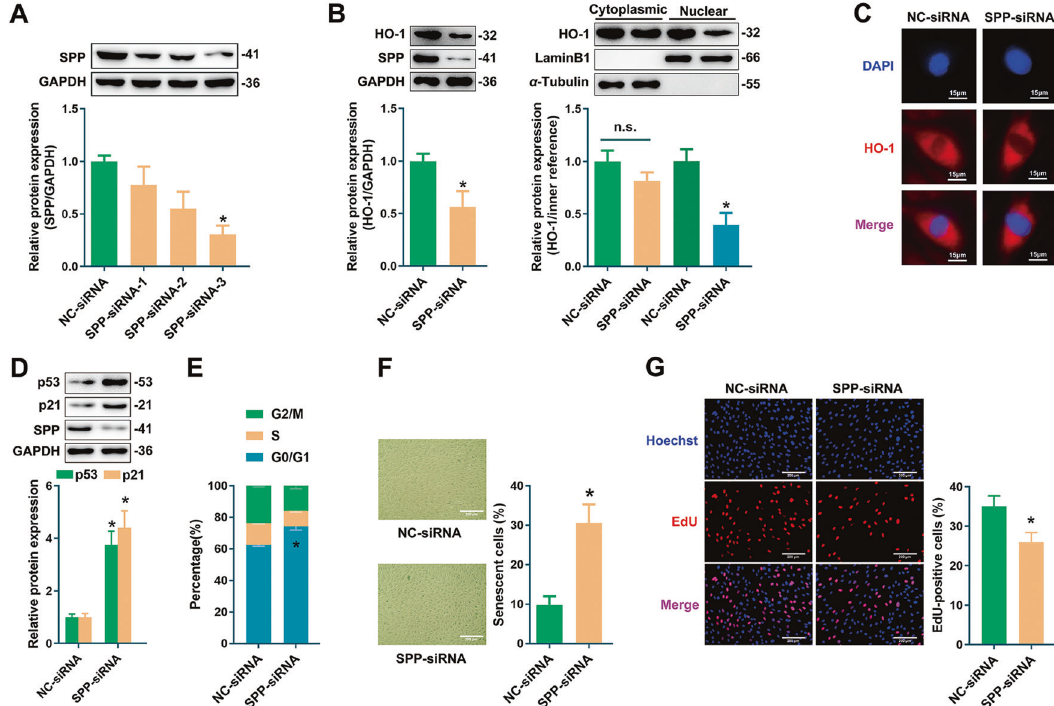
Fig. 4 Reducing nuclear HO-1 by SPP knockdown exacerbated endothelial senescence. A Screening of SPP interference sequences by Western blot. Sequence-3 was used for the following experiments. * P < 0.05 vs. NC-siRNA. n = 5. B Silencing of SPP decreased the expression of nuclear HO-1 rather than cytoplasmic HO-1. * P < 0.05 vs. NC-siRNA. n = 5. C Silencing of SPP reduced fl uorescence signal of nuclear HO-1. n = 3. D Silencing of SPP increased the expression of p53 or p21. * P < 0.05 vs. NC-siRNA. n = 5. E Silencing of SPP increased the percentage cells at G0/G1 phase. * P < 0.05 vs. NC-siRNA. n = 5. F Silencing of SPP increased the proportion of SA- β -gal staining cells. * P < 0.05 vs. NC-siRNA. n = 5. G Silencing of SPP decreased the ratio of EdU-positive cells. * P < 0.05 vs. NC-siRNA. n =